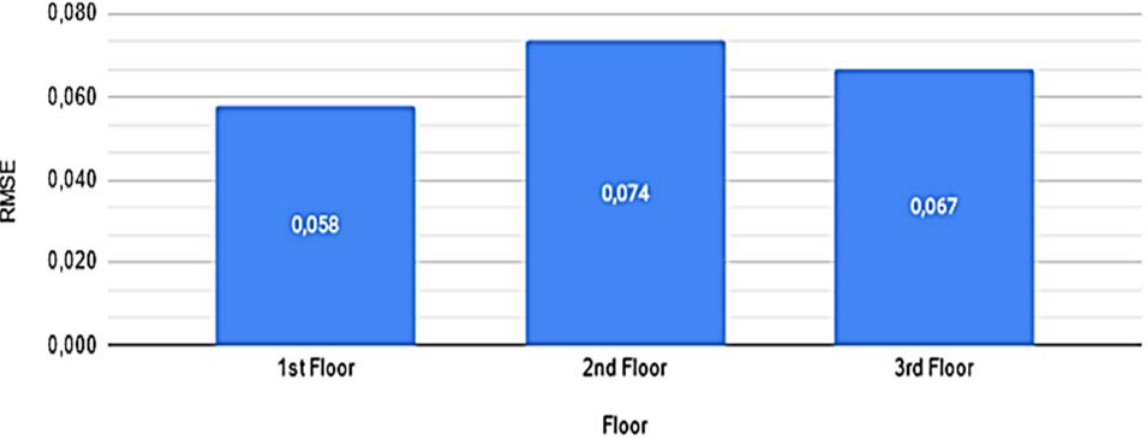
Figure 30. Average RMSE concerning floor for the validation set.